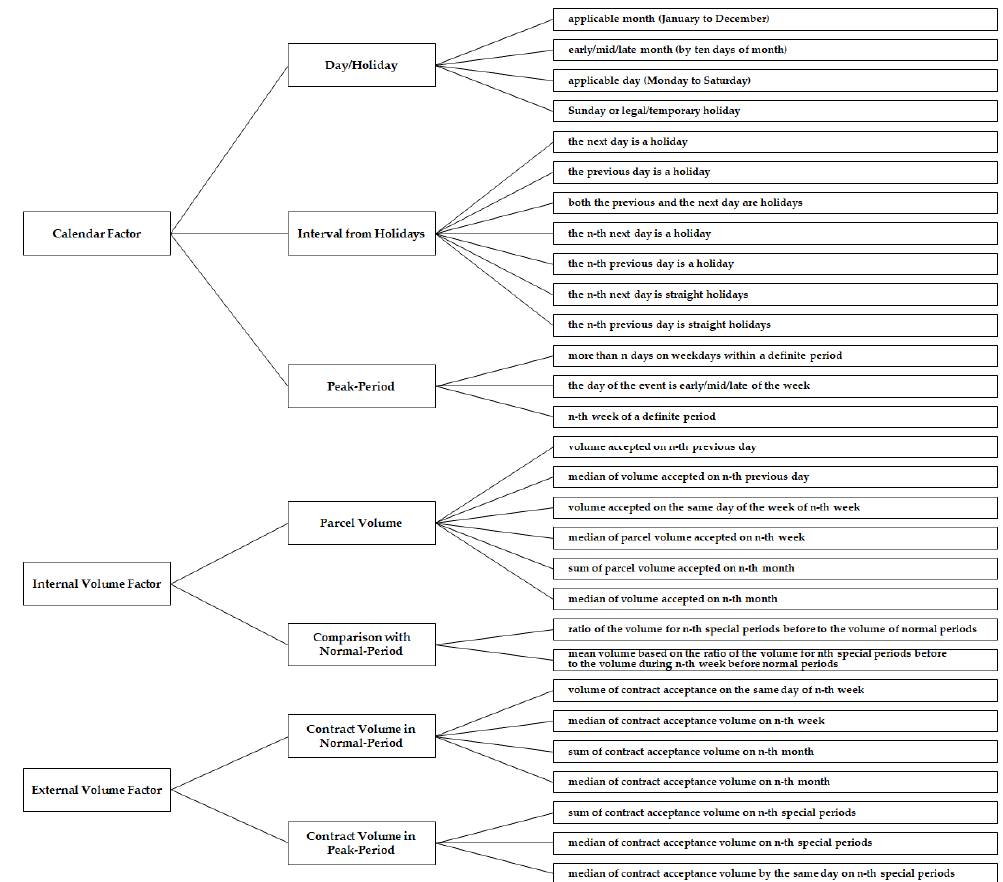
Figure 1. Feature-set by internal and external factors.